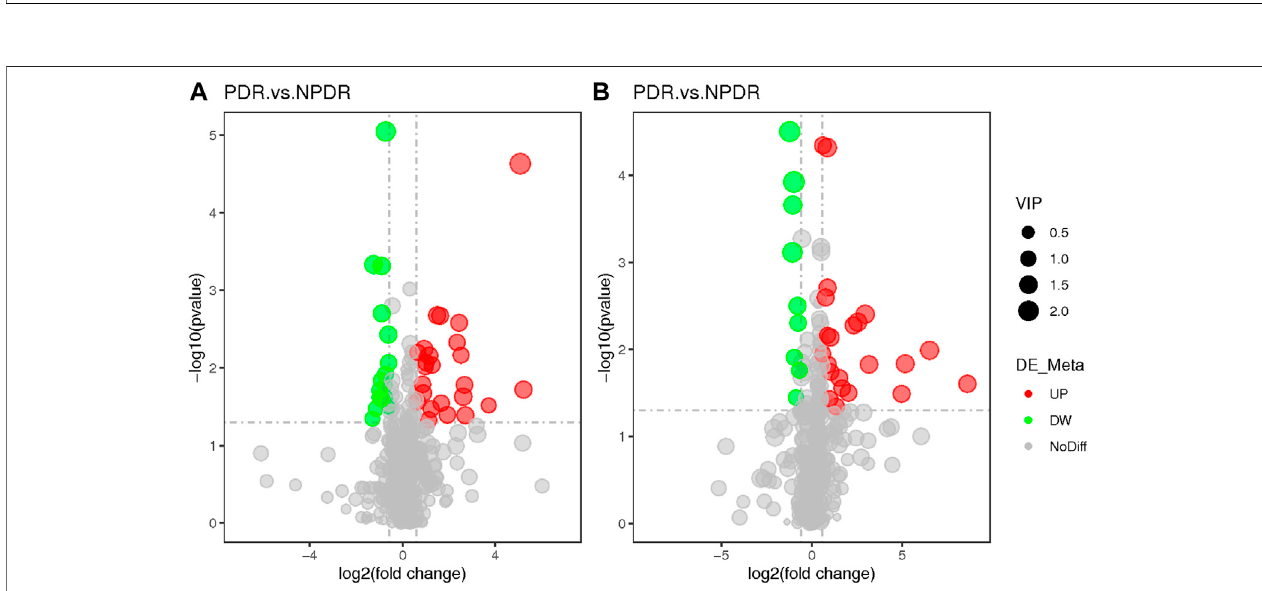
FIGURE8|(A) Positivemode. (B) Negativemode.Hierarchicalclusteringanalysisbasedontheintensityofsigni fi cantmetabolitefeaturesselectedbyPLS-DAwith a VIP > 1.0 identi fi ed clusters of features that were increased (red) or decreased (blue) in PDR patients and NPDR patients. There are 61 metabolic features shown in positive mode and 61 metabolic features shown in negative mode.